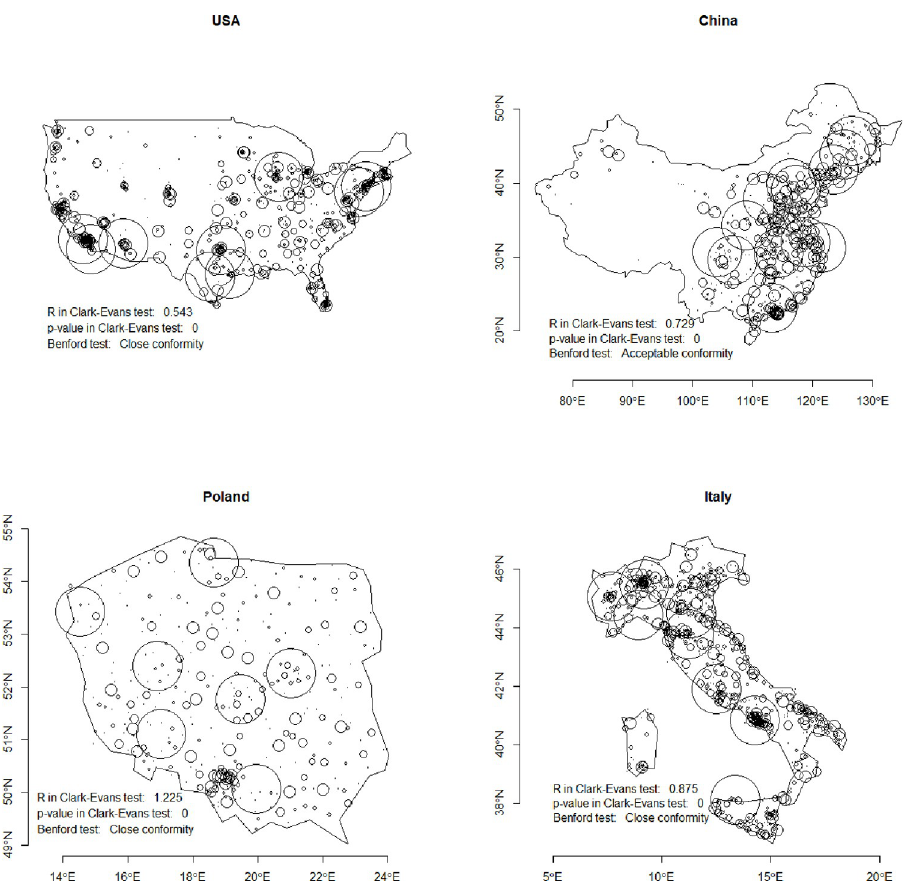
Fig 7. Locations of cities in selected countries, where for 3D socio-geo distance the conformity to Benford’s law was achieved: a) USA, b) China, c) Poland, d) Italy. Source: Own study with the use of benford.analysis::, spatstat::, maps::, rworldmap:: R